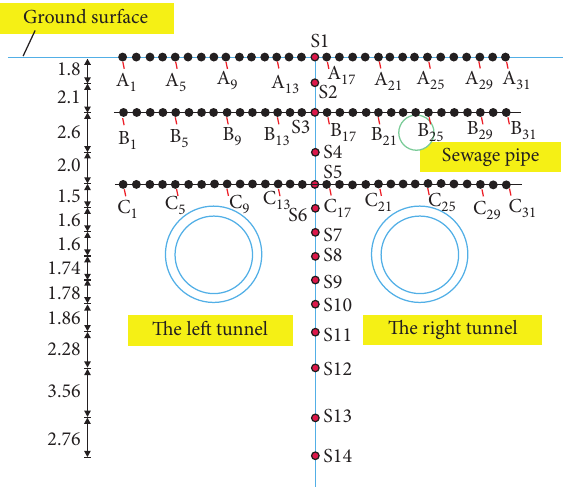
Figure 15: Layout of observation points in numerical simulation.